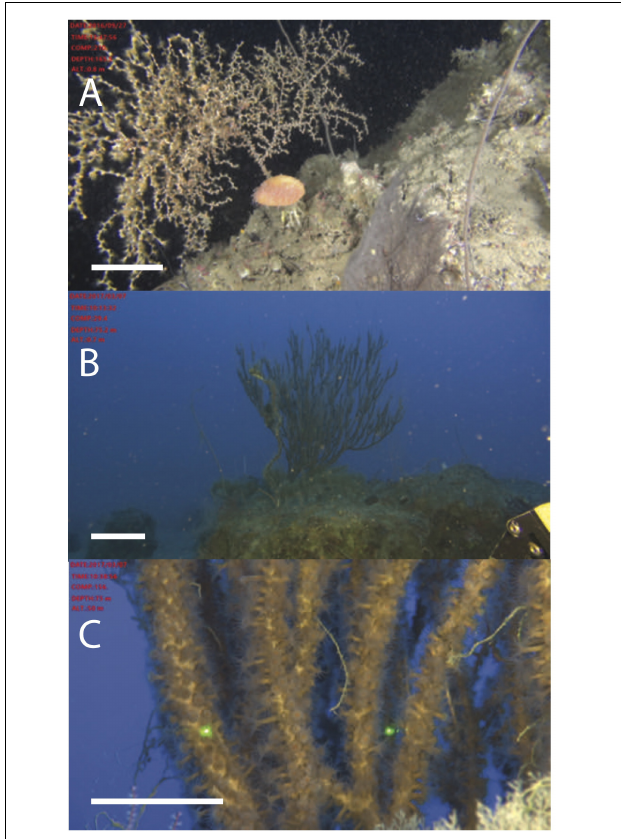
FIGURE 3 | Zoantharian specimens collected from Israel phylogenetically examined in this study. (A) Antipathozoanthus sp. ZMTAU Co 37440 colony in situ at 170 m, (B) Parazoanthidae sp. 2 ZMTAU Co 37525 colony in situ at 173 m, and (C) closeup of the same colony. Scale bars: A, B = approximately 10 cm; C = approximately 5